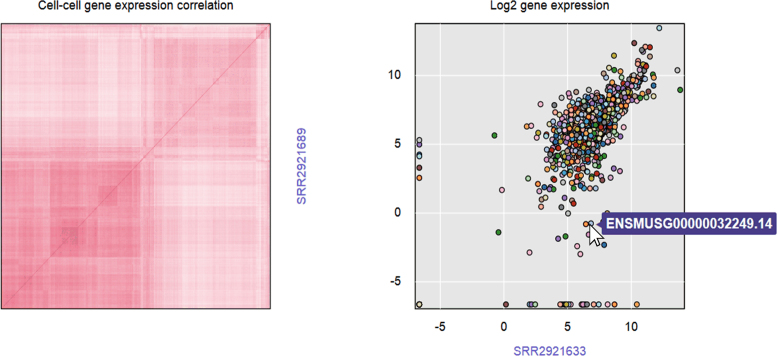
Example of computed gene expression correlation matrix. The correlation matrix as implemented in SCPortalen. It shows the gene expression correlation for the dataset titled Identification of novel regulators of Th17 cell pathogenicity by single-cell genomics (18). In the figure the y- and x-axis is the cell_id. The color of each dot in the right panel represents the level of the gene expression. When users hover over any dot, its Gencode ID will display.